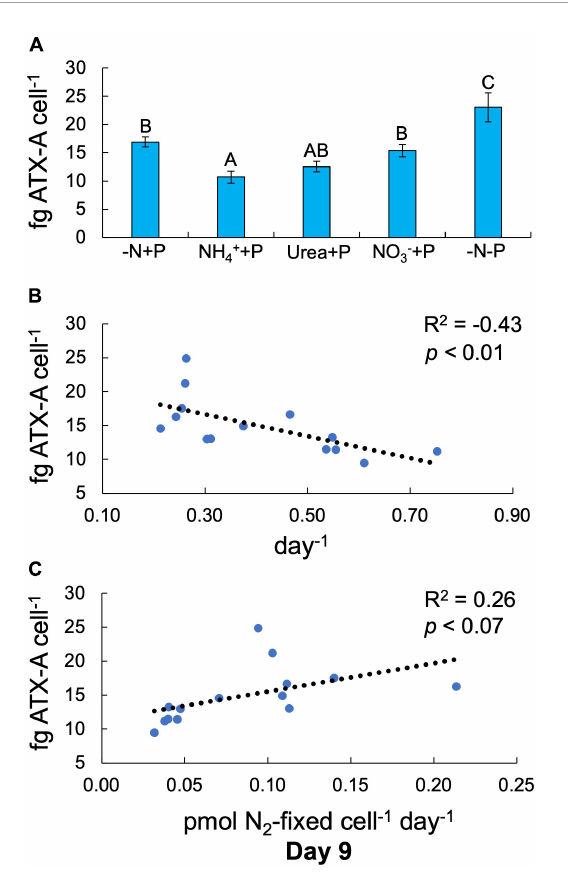
FIGURE4 Anatoxin-a (ATX-A) content per cell (fg ATX-A cell − 1 ) across treatments at the final timepoint [day 9; (A) ]. Error bars represent standard deviation. Letters above bars represent significant differences between experimental groups (Two-way ANOVA; Tukey’s HSD post hoc ; p < 0.05). Anatoxin-a (ATX-A) content per cell as functions of maximum growth rate [ (B) ; µ max ; day − 1 ] and N 2 fixation (C) . Values in the upper right-hand corners represent coefficients of determination (R 2 ) and the significance ( p -value) of linear